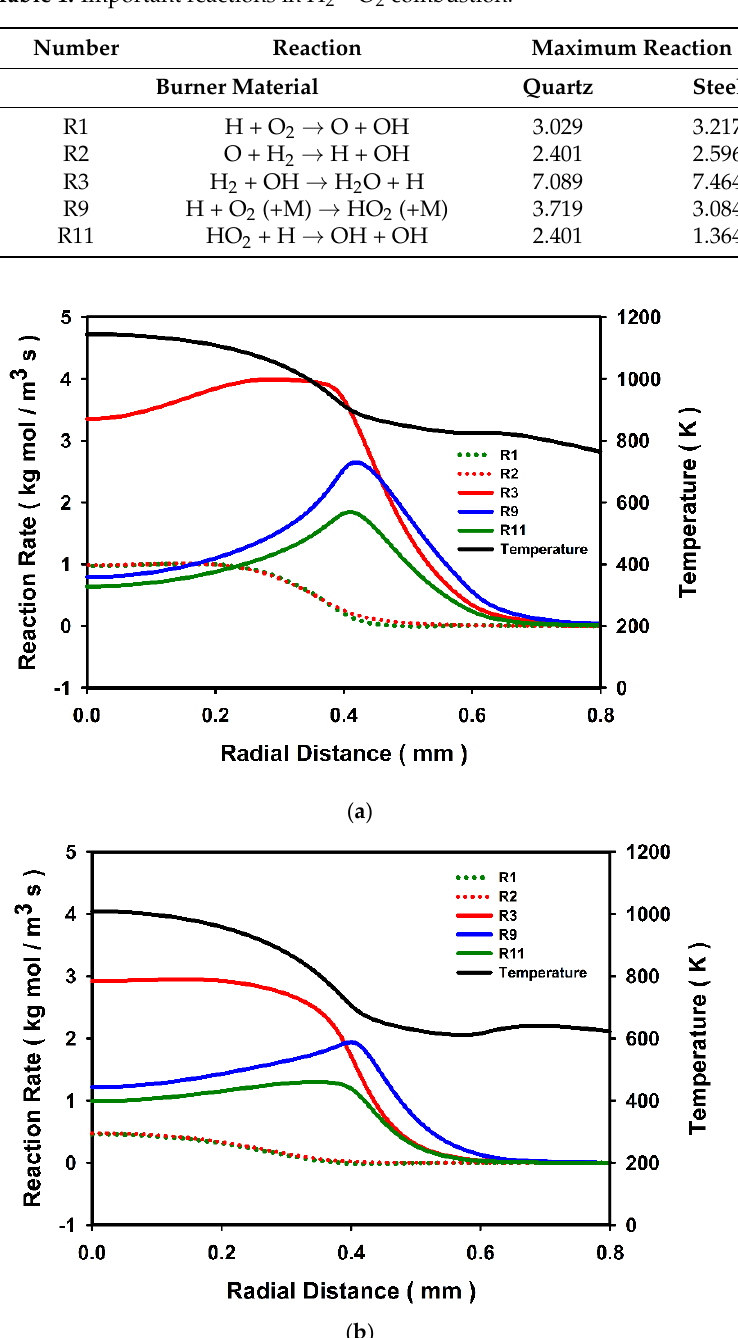
Table 1. Important reactions in H 2 —O 2 combustion.